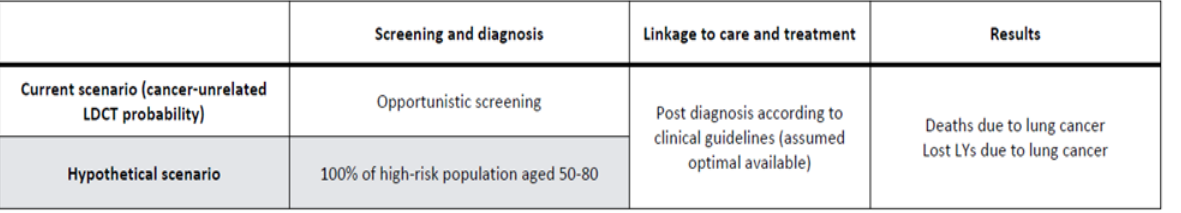
Figure 1 : Current and hypothetical scenario for LCLY.